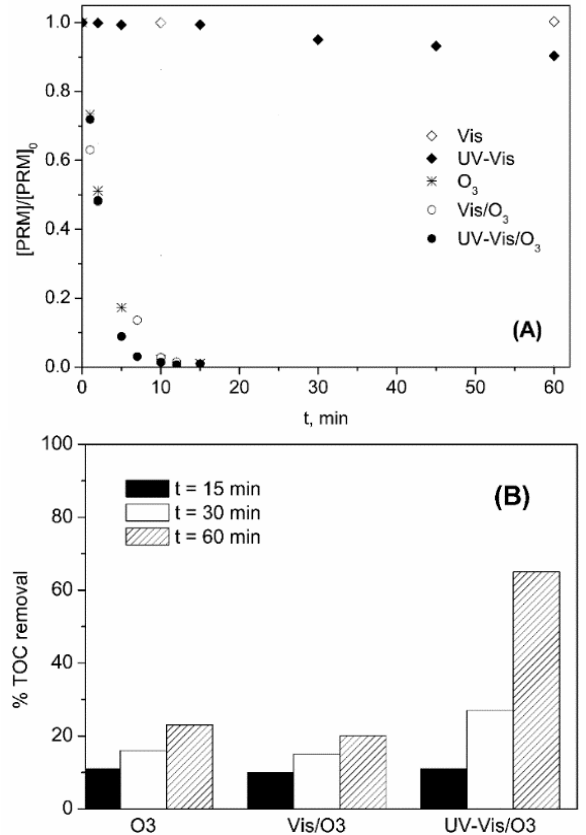
Figure 2. Variation with time of PRM normalized concentration ( A ) and percentage of TOC removed ( B ) during the application of different processes in ultrapure water. Experimental conditions: [PRM] 0 = 5 mg L − 1 ; [TOC] 0 = 3.3 mg L − 1 ; pH 0 ~6 (natural pH); Q m,O3 = 3.3 mg min − 1 ; T = 20–30 °C; I Vis = 7.75 × 10 − 5 Einstein L − 1 s − 1 ; I UV-Vis = 8.2 × 10 − 5 Einstein L − 1 s − 1 .